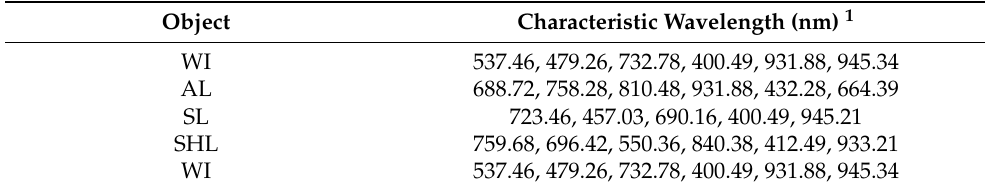
Table 6. The characteristic wavelengths of different objects using the successive projections algo- rithm (SPA).